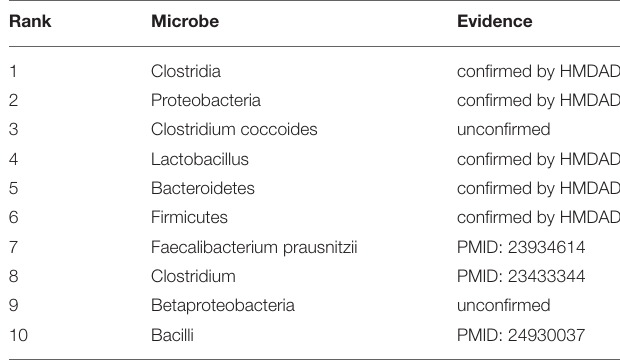
TABLE 2 | Prediction list of the top 10 potential obesity-related microbes based on the known associations in HMDAD database and the corresponding validation evidences (experimental literatures in PubMed) for these associations.